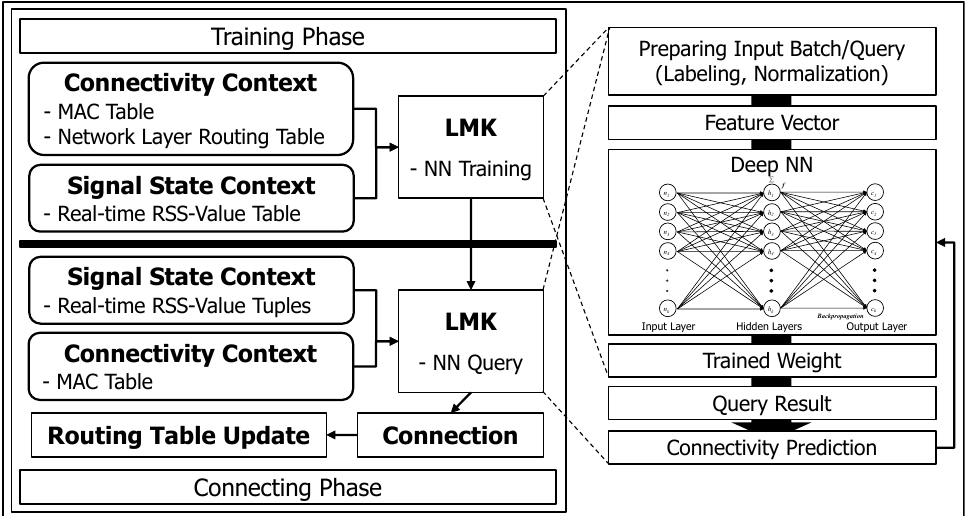
Figure 2. Fast Connectivity Construction Framework with On-node Training and